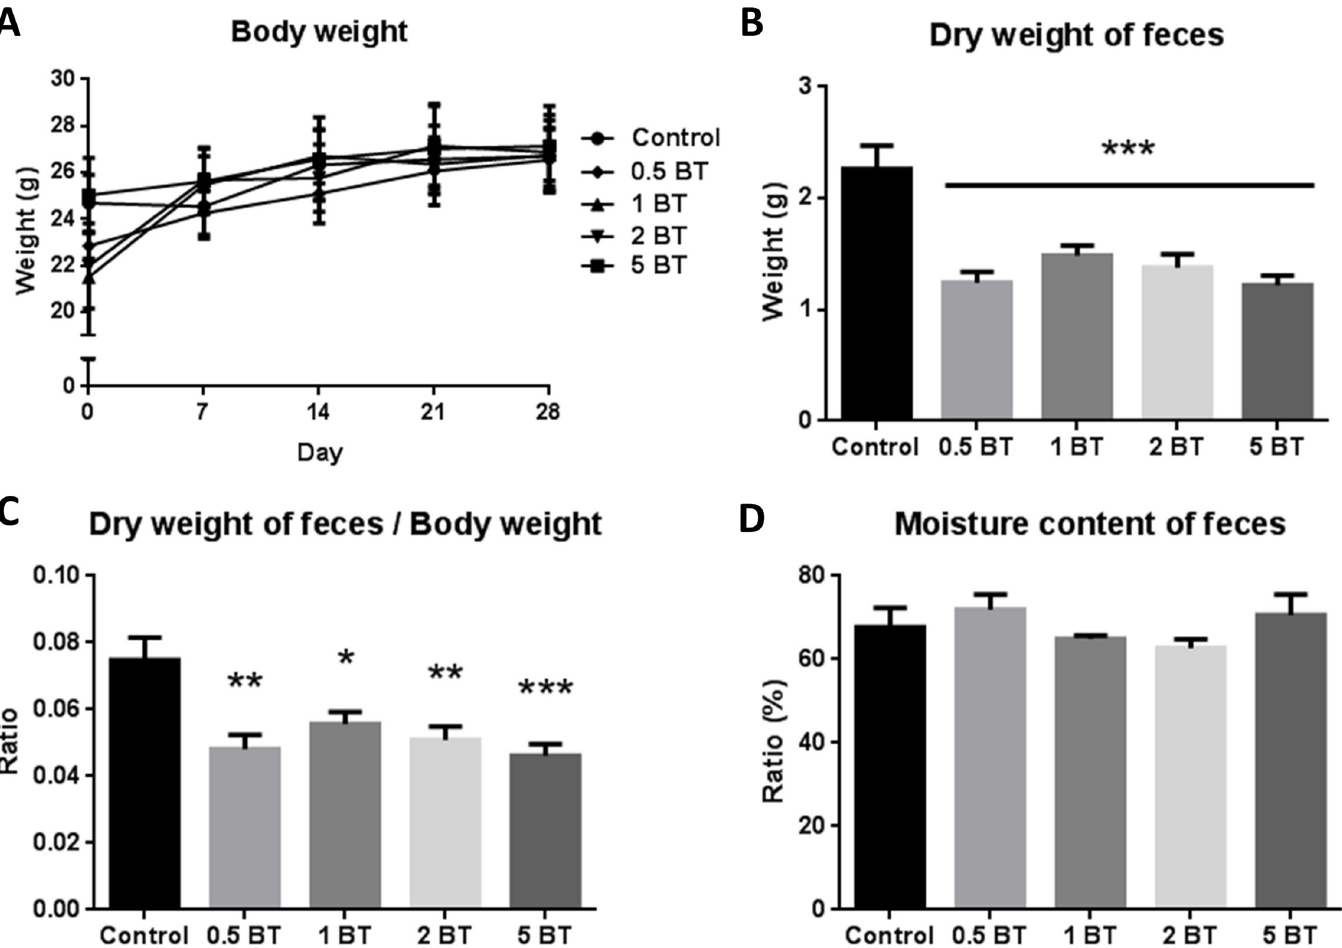
Fig 3. Status of animals and defecation recording. The effects of drinking BT on the physiological parameters of body weight (A), dry weight of feces (B), the ratio of dry weight of feces to body weight (C), and moisture content of feces (D) in these five groups of mice (n = 10). All types of BT decreased dry weight of feces. The data are mean ± SEM and analyzed by one-way ANOVA. � P < 0.05; �� P < 0.01; ��� P <